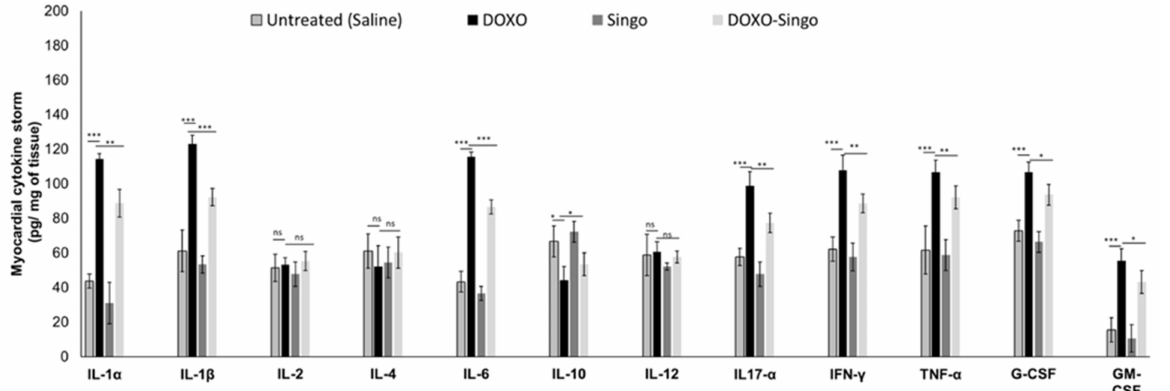
Figure 6. Myocardial cytokines, chemokines and growth factors in preclinical models of DOXO- induced cardiotoxicity (IL-1 α , IL-1 β , IL-2, IL-4, IL-6, IL-10, IL-12, IL-17 α , IL-18, IFN- γ , TNF- α , G-CSF and GM-CSF). Results: mean +/ − SD. p -values for the indicated compounds relative to untreated mice are: ns: not significant. *** p < 0.001. ** p < 0.01. * p <